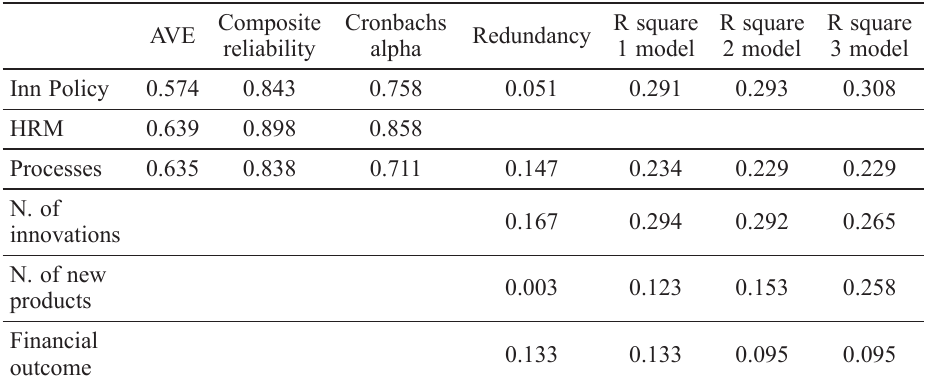
Table 3. Model quality